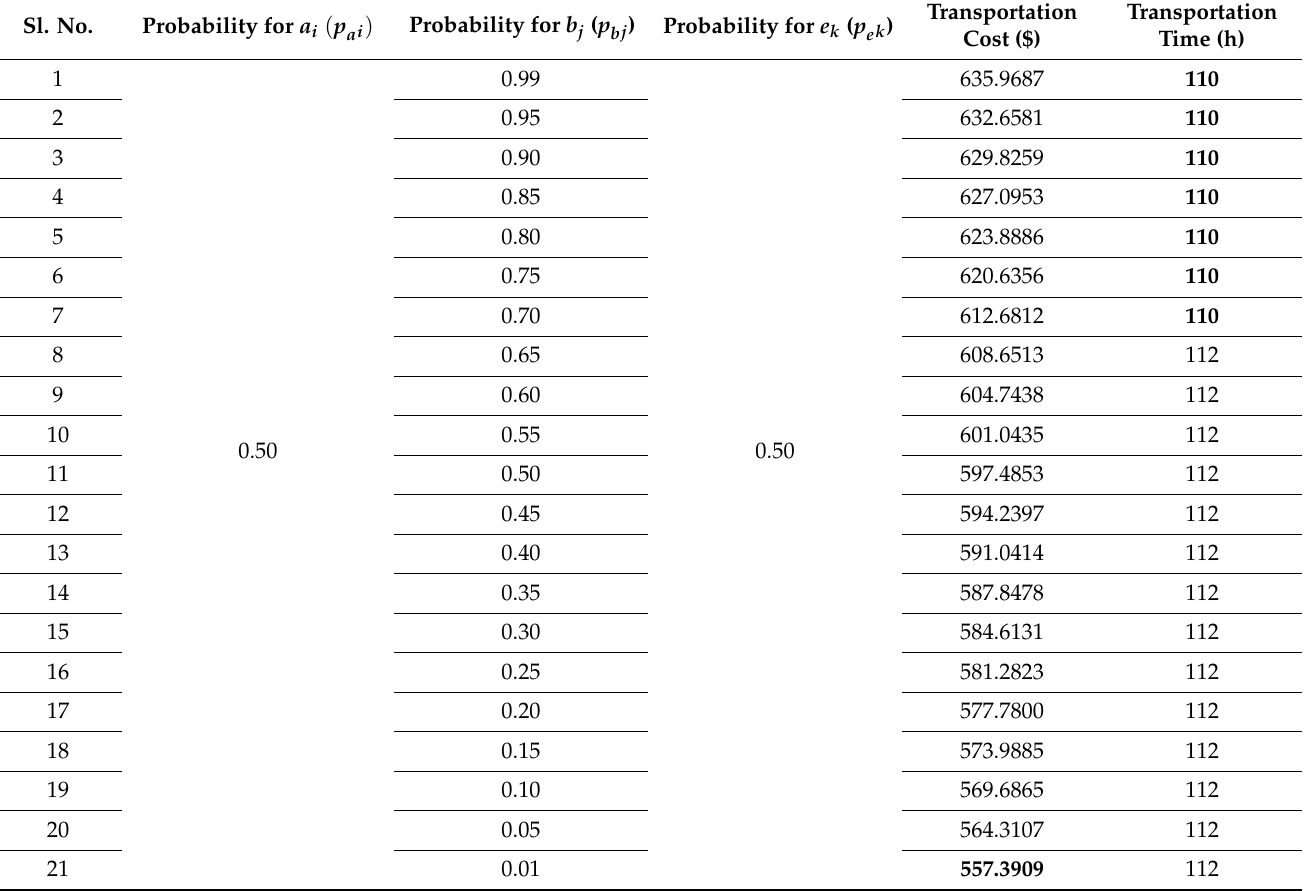
Table 8. Sensitivity analysis concerning the probability for b j .